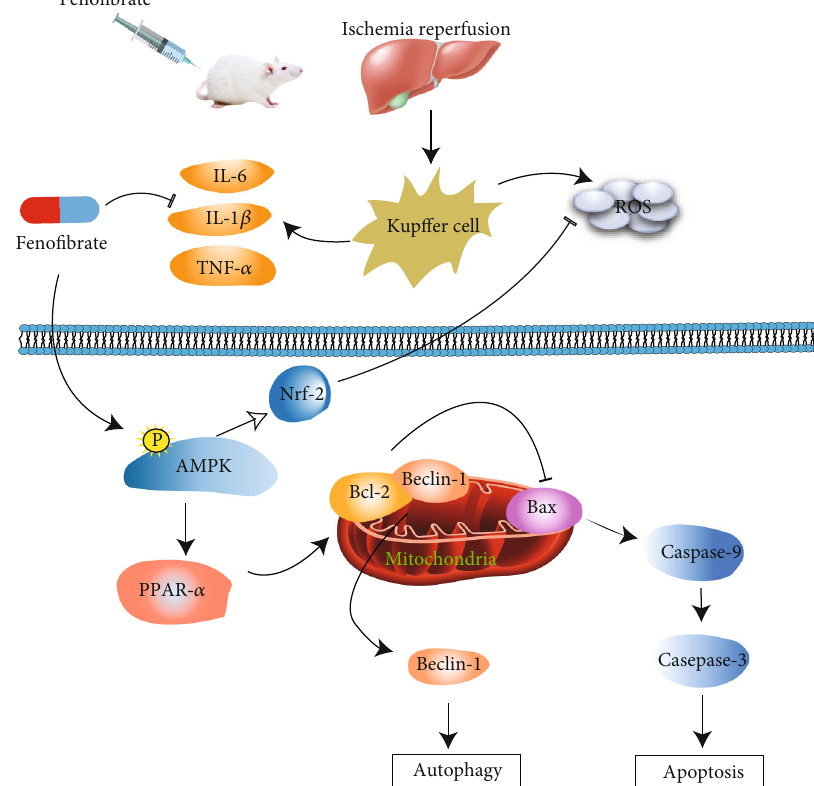
Figure 6: Possible mechanisms of feno fi brate during hepatic IR injury. In our IR-induced liver injury model, activated Kup ff er cells promoted the release of proin fl ammatory cytokines such as TNF- α , IL-1 β , and IL-6 and production of ROS. Feno fi brate can activate PPAR- α via phosphorylating AMPK, collaboratively regulating in fl ammation response, apoptosis, and autophagy downstream. Furthermore, AMPK activation increased accumulation of Nrf-2 to reduce ROS generation. FF shows hepatoprotective e ff ects against IR injury by inhibiting in fl ammation and attenuating apoptosis and autophagy through the AMPK/PPAR- α